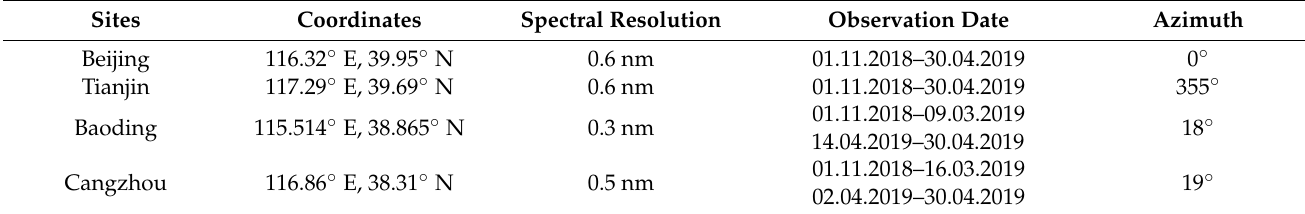
Table 2. Details of the MAX-DOAS ground-based sampling locations in the North China Plain (NCP). Sites Coordinates Spectral Resolution Observation Date Azimuth 116.32 ◦ E, 39.95 ◦